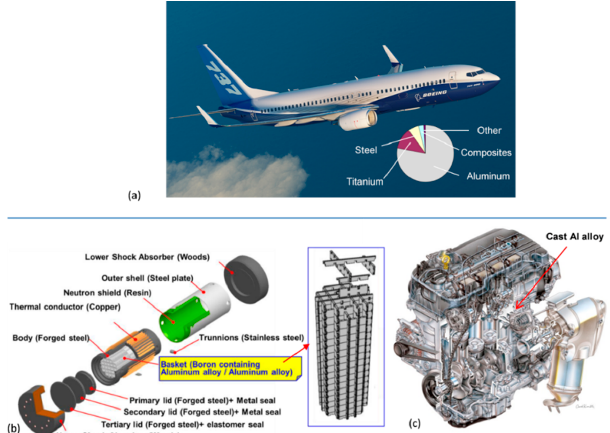
Figure 4. Applications of aluminum alloys requiring thermal stability at di ff erent temperatures: ( a ) commercial airplane with aluminum surface components exposed to room and slightly elevated temperatures [5]; ( b ) packaging and transportation of radioactive materials: long-term storage / transportation casks for spent fuels in nuclear power plants, requiring exposure to temperature 100–200 ◦ C for over 60 years [6]; and ( c ) automotive combustion engine with new designs requiring temperature over 200 ◦ C